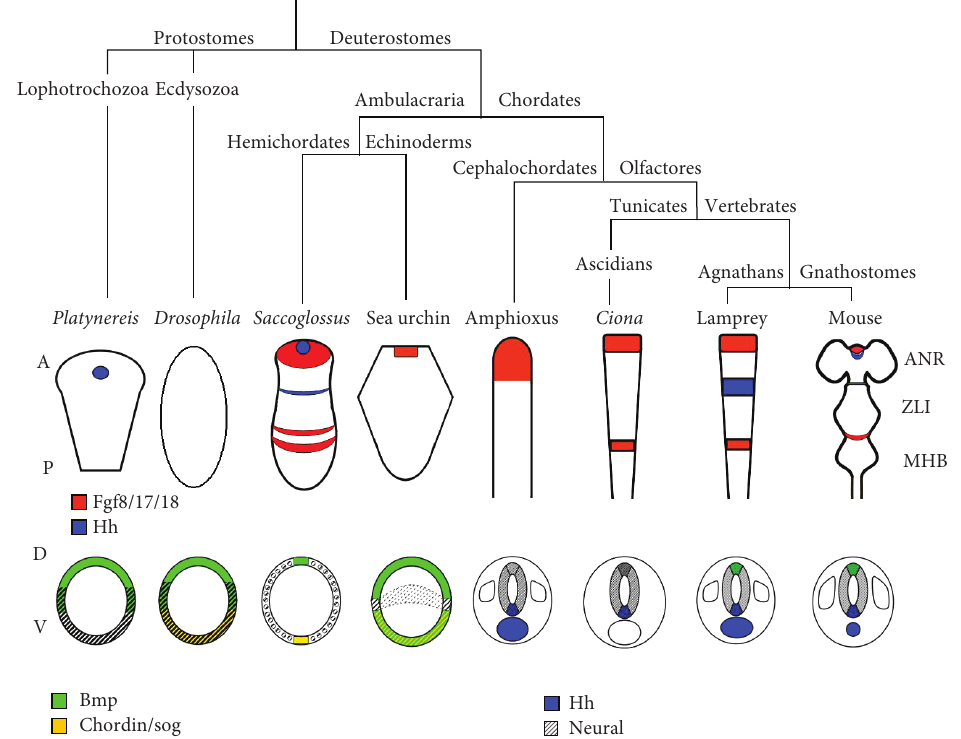
F 2: Phylogenetic tree leading to model organisms discussed in this paper. Signalling factor expression domains along the anteroposterior (AP) and dorsoventral (DV) axes are